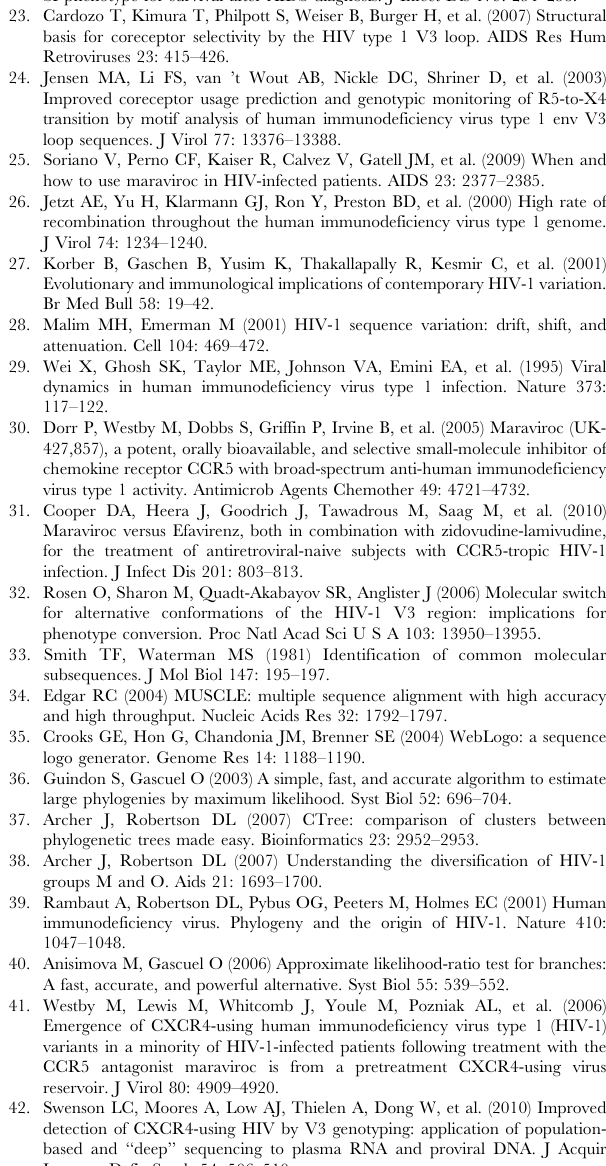
Figure S1 Example of frame correction to a dataset specific template and HXB2. Pairwise alignment of the V3 region of the consensus template (patient D, screening) to that of HXB2 (A).